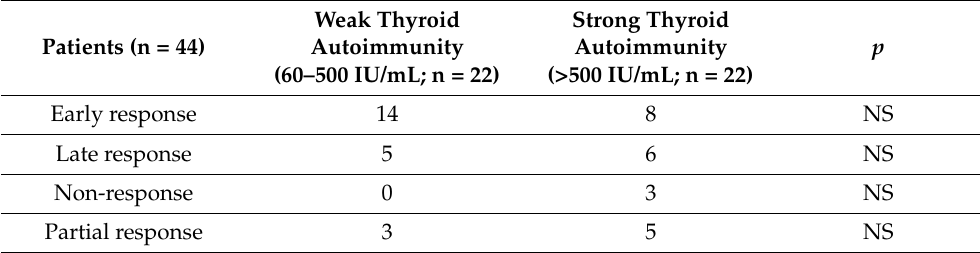
Table 2. Clinical response to omalizumab as a function of the level of thyroid peroxidase IgG.